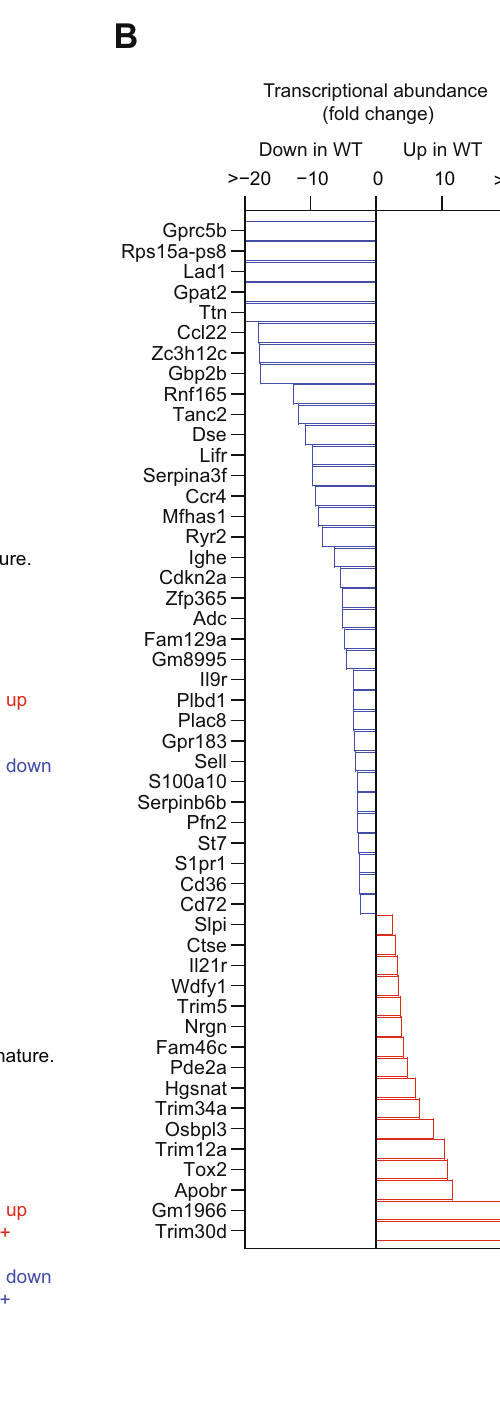
with IL-21 affecting population dynamics — such as the rate of transition between LZ and DZ — rather than gene expression per se. Using the limma barcode approach for gene set enrichment analysis (see “ Methods ” ), we compared these DE genes with an existing GC zone signature 42 , which revealed enrichment of DZ signature genes among transcripts up in WT vs Il21r − / − and LZ signature enrichment among those up in Il21r − / − vs WT (Fig. 5C).